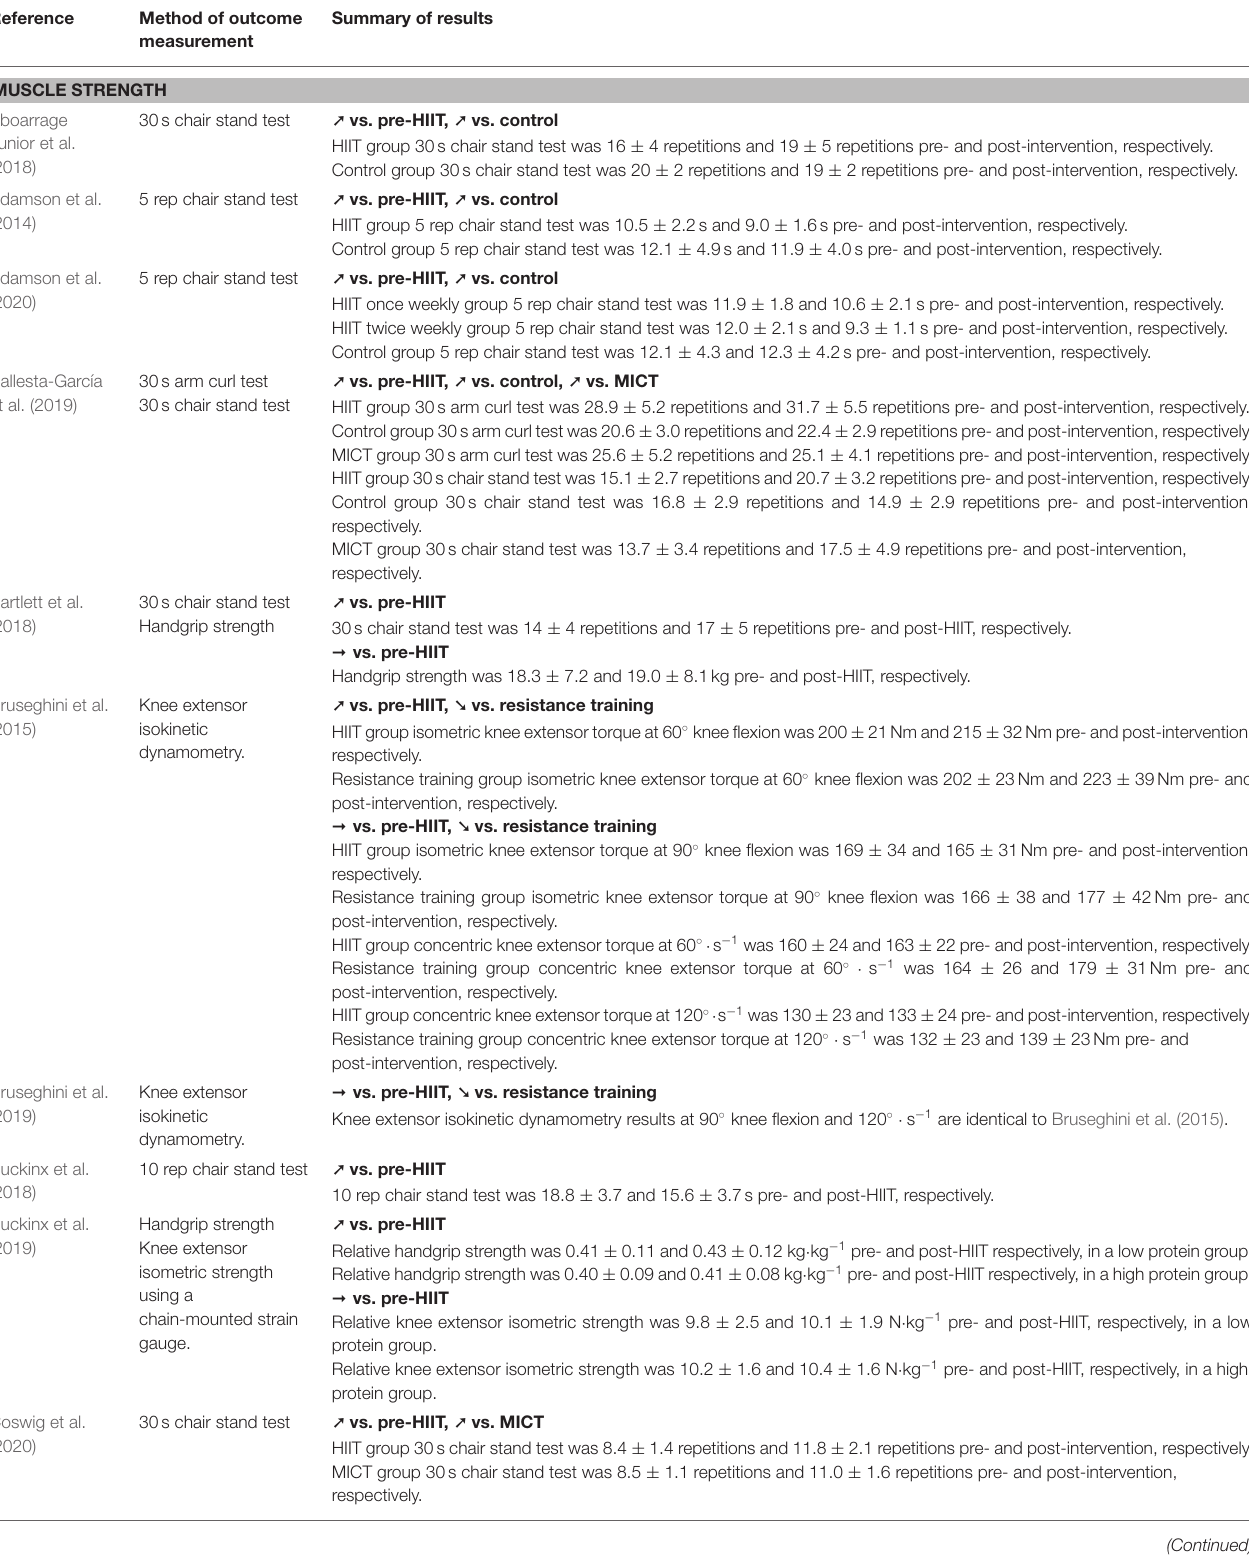
TABLE 2 | Summary of study details concerning HIIT and muscle